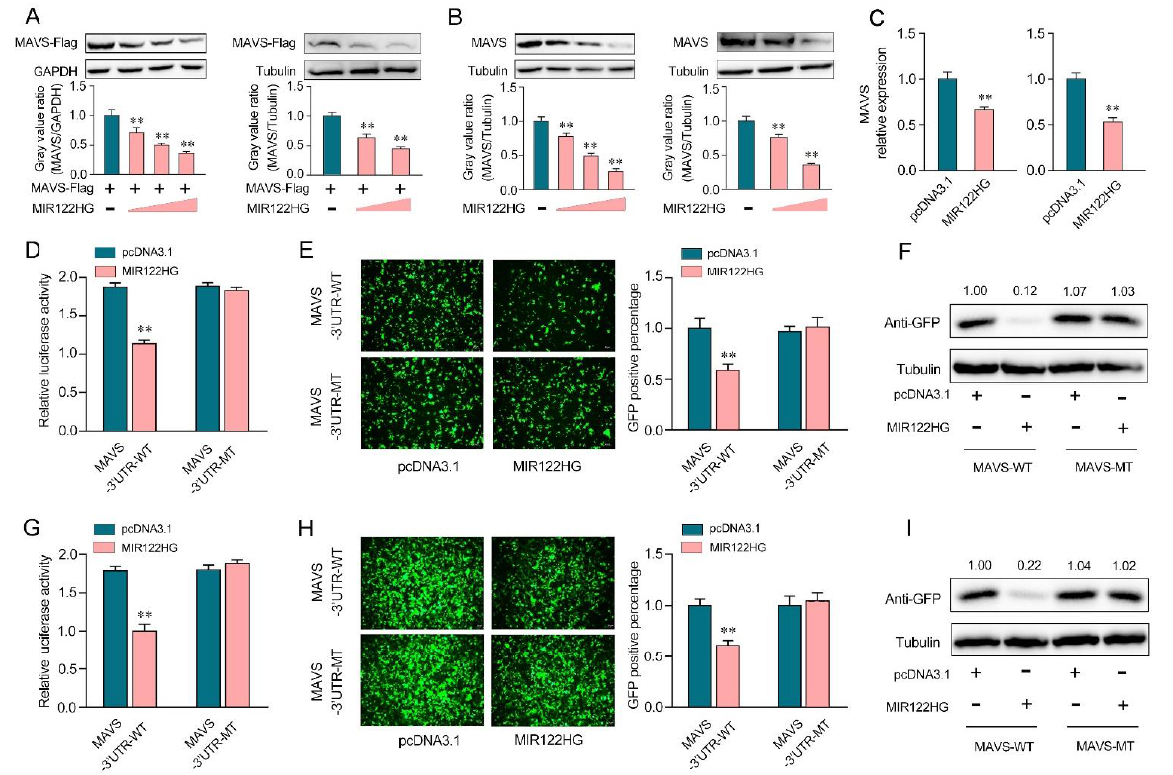
Figure 2. MIR122HG inhibits miiuy croaker MAVS gene. ( A ) EPC cells (left panel) were cotransfected with the MAVS expression plasmid with a flag tag, together with MIR122HG plasmid (0, 100, 200, and 400 ng) or pcDNA3.1 (400, 300, 200, and 0 ng). After 48 h transfection, MAVS expression was measured by Western blotting (upper panel), and the gray value ratio about MAVS/GAPDH (left panel) was shown in the lower panel. HEK293 cells (right panel) were cotransfected with the MAVS expression plasmid with a flag tag, together with MIR122HG plasmid (0, 200, and 400 ng) or pcDNA3.1 (400, 200, and 0 ng). After 48 h transfection, MAVS expression was measured by Western blotting (upper panel), and the gray value ratio about MAVS/Tubulin was shown in the lower panel. ( B ) MKCs (left panel) were transfected with MIR122HG plasmid (0, 100, 200, and 400 ng) or pcDNA3.1 (400, 300, 200, and 0 ng) for 48 h, MAVS expression was determined by Western blotting (upper panel), and the gray value ratio about MAVS/Tubulin was shown in the lower panel. MICs (right panel) were transfected with MIR122HG plasmid (0, 200, and 400 ng) or pcDNA3.1 (400, 200, and 0 ng) for 48 h, MAVS expression was determined by Western blotting (upper panel), and the gray value ratio about MAVS/Tubulin was shown in the lower panel. ( C ) MKCs (left panel) and MICs (right panel) were cotransfected with MIR122HG or pcDNA3.1. After 24 h of transfection, the expression levels of MAVS were determined by qPCR. ( D ) EPC cells were cotransfected with MIR122HG or pcDNA3.1, along with MAVS 3′ -UTR-WT or MAVS 3′ -UTR-MT for 24 h, and then the luciferase activity was measured. ( E , F ) MIR122HG or pcDNA3.1was cotransfected with the wild- or mutant-type mVenus-MAVS 3′ -UTR into EPC cells, respectively. At 48 h post-transfection, the fluorescence intensity ( E ) and the GFP expression ( F ) were evaluated by enzyme-labeled instrument and Western blotting, respectively. ( G ) HEK293 cells were cotransfected with MIR122HG or pcDNA3.1, along with MAVS 3′ -UTR-WT or MAVS 3′ -UTR-MT for 24 h, and then the luciferase activity was measured. ( H , I ) MIR122HGor pcDNA3.1wascotransfected with the wild- or mutant-type mVenus-MAVS 3′ -UTRinto HEK293 cells, respectively, for 48 h transfection; the fluorescence intensity ( H ) and the GFP expression ( I ) were evaluated by enzyme-labeled instrument and Western blotting. The scale bar represents 20 μm; original magnification, × 10. The luciferase activity was analyzed and normalized to Renilla luciferase activity. All data are presented as the means ± SE from at least three independent triplicate experiments. **, p < 0.01 forthe